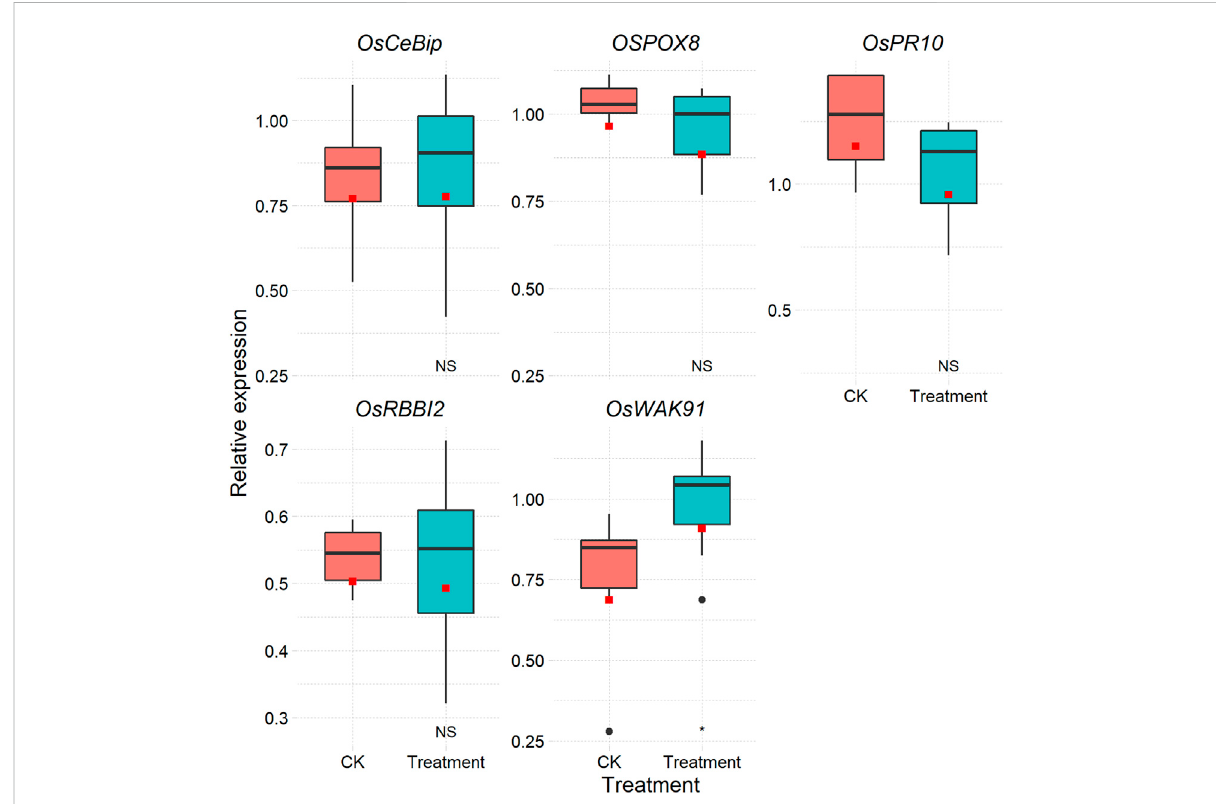
FIGURE 2 Box plot of each gene in different treatments based on the relative standard curve